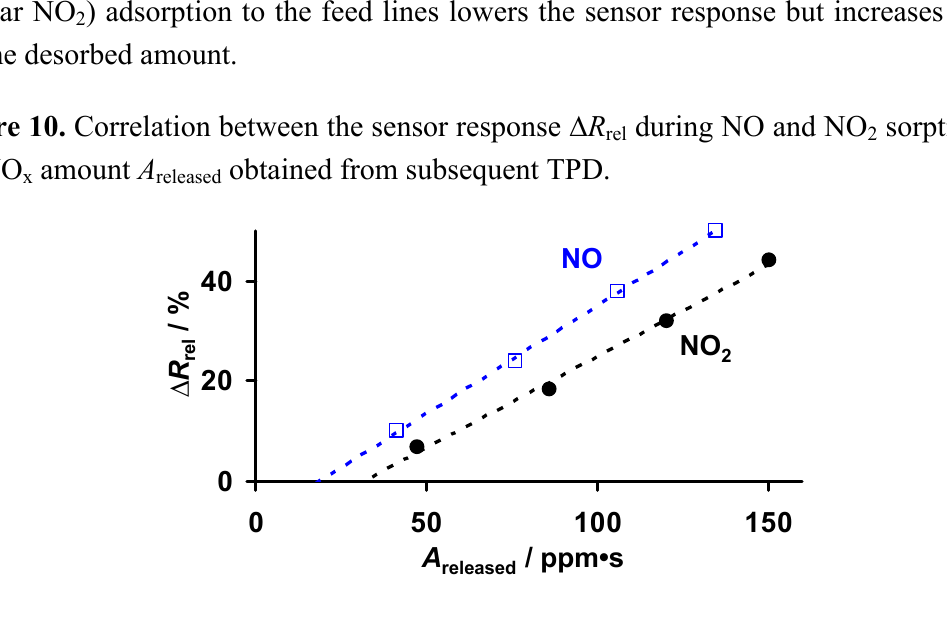
during NO and NO rel